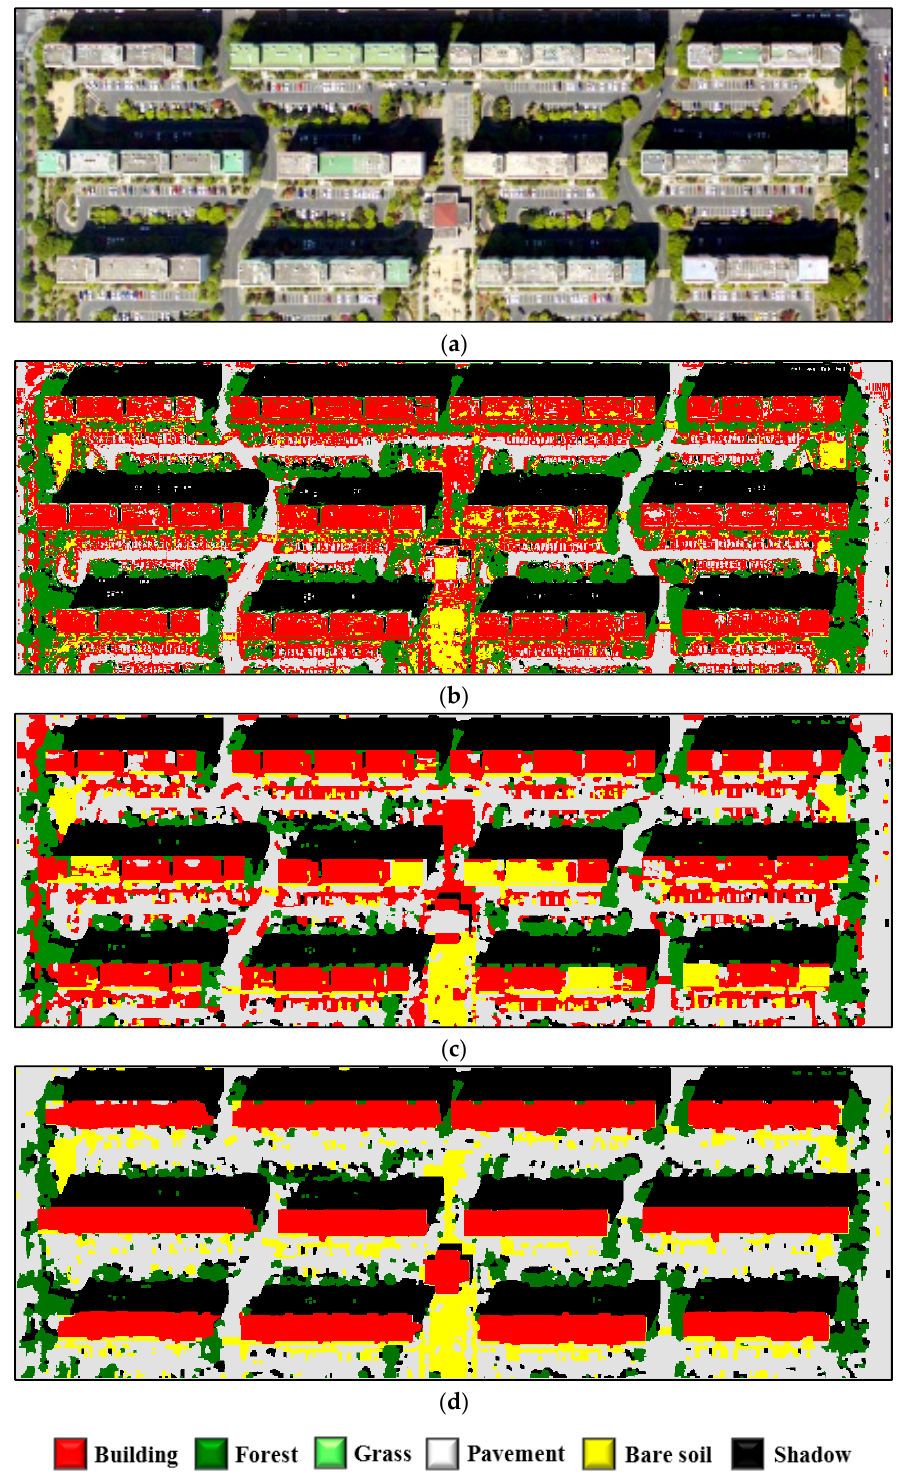
Figure 8. Final results for site 3: ( a ) aerial image; ( b ) Max-Min method; ( c ) SSI, nDSM method; and ( d ) the new method.